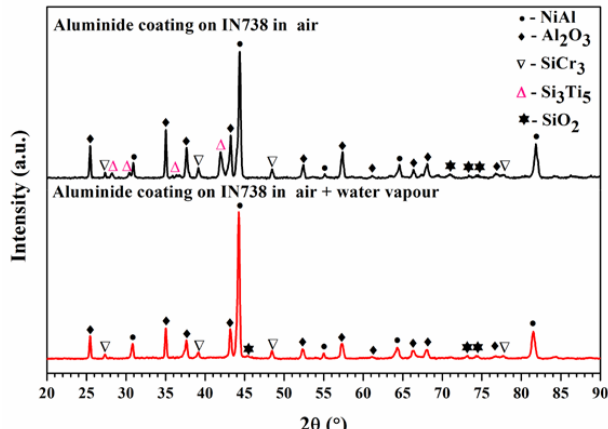
Figure 1. Cyclic oxidation kinetics of aluminide coating on an IN738 superalloy in air and air plus water vapour after being oxidized at 1050 °C for 150 h.